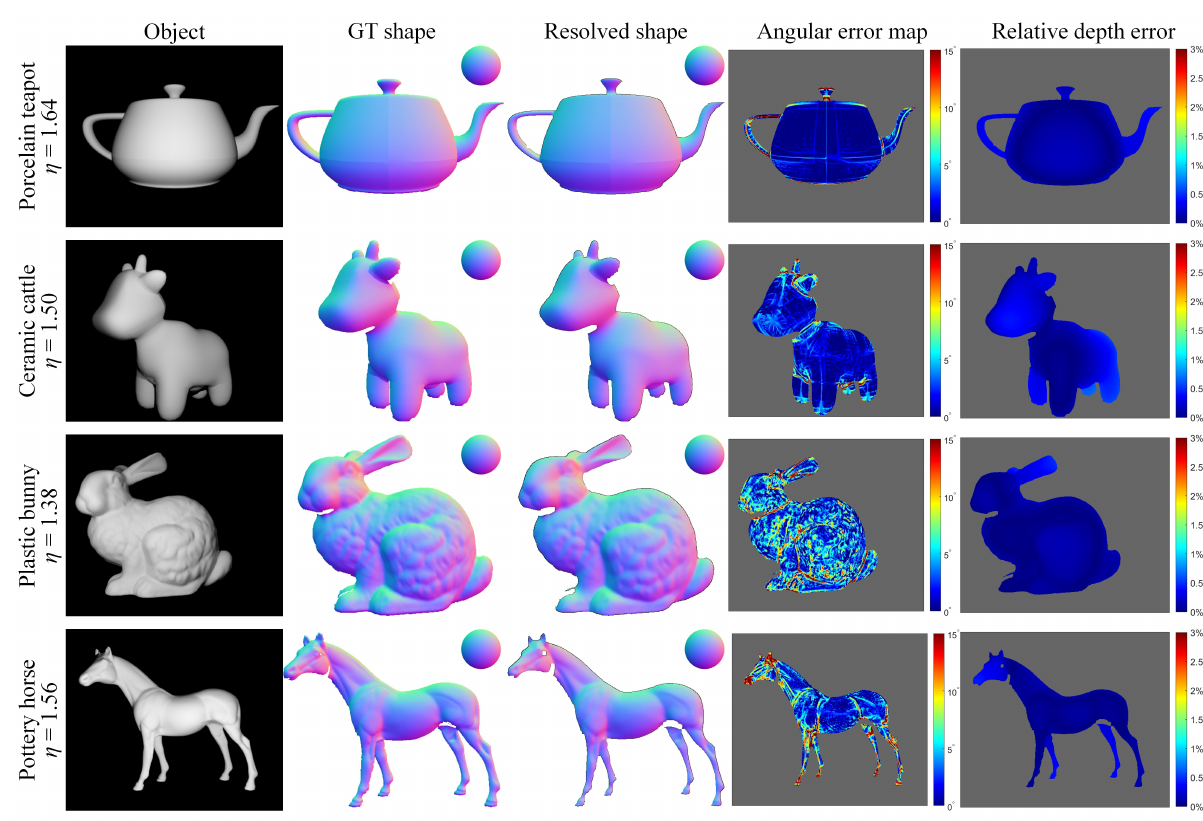
Figure 2. Qualitative normal and depth estimation results on synthetic data of different materials with uniform